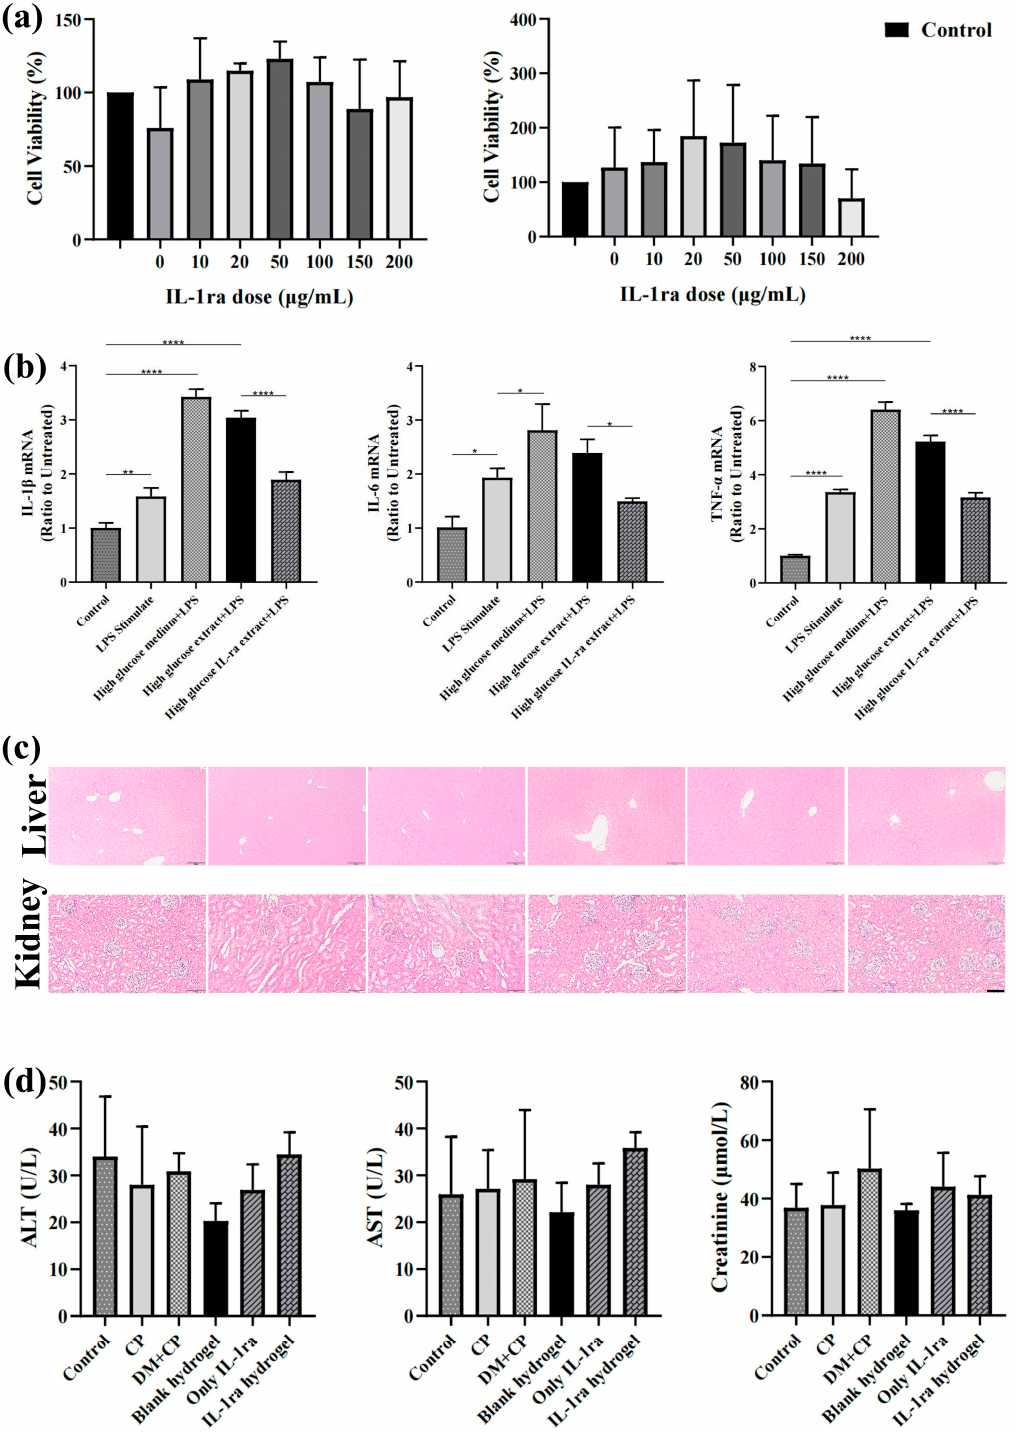
Figure 2. Biocompatibility and anti-inflammatory factor characteristics of IL-1ra-loaded CS/ β - GP/gelatin thermosensitive hydrogel. ( a ) Viability of RAW 264.7 cells cultured with IL-1ra-loaded CS/ β -GP/gelatin thermosensitive hydrogels at different concentrations (10–200 μ g/mL) at 24 h and 48 h. ( b ) Fold change of IL-1 β , IL-6, and TNF- α mRNA expression in the blank control, LPS stimu- lated, High glucose medium+ LPS stimulated, High glucose extract + LPS stimulated, High glu- cose extract + LPS + IL-1ra-loaded CS/ β -GP/gelatin thermosensitive hydrogel groups ( n = 3). ( c ) H&E staining of liver and kidney tissue in the groups I, II, III, IV, V, and VI, scale bar represents 100 μ m. ( d ) Effect of IL-1ra-loaded CS/ β -GP/gelatin thermosensitive hydrogels on serum creati- nine (Cr), aspartate transaminase (AST), and alanine transaminase (ALT) levels. *: p < 0.05, **: p < 0.01, ****: p < 0.0001. 2.3. IL-1ra CS/ β -GP/Gel Hydrogel Decreased the mRNA Expression of Inflammatory Factors Our in vitro (Figure 2b) and in vivo (Figure 3a) experiments showed similar mRNA expressions of inflammatory factors. The results of cell experiments showed that the mRNA expression of IL-1 β , IL-6, and TNF- α of RAW264.7 cells stimulated with LPS was 1.58 times, 1.91 times, and 3.35 times higher than those of untreated cells, and the ex- pression of these three cytokines increased by 2.16 times, 1.45 times, and 1.91 times, re- spectively, after high glucose culture. The expression of these inflammatory cytokines decreased significantly after treatment with IL-1ra CS/ β -GP/Gel hydrogel extract. In an- imal experiments, the mRNA expression of IL-1 β , IL-6, and TNF- α in rats with simple periodontitis was 2.63 times, 2.79 times, and 4.18 times higher than those in healthy rats, and the mRNA expression of these cytokines in rats with diabetes increased by 1.78 times, 1.58 times, and 3.04 times, respectively. The expression of inflammatory factors af- ter treatment with IL-1ra alone and blank hydrogel was not significantly different from that in the diabetic periodontitis group but was significantly decreased in the IL-1ra CS/ β -GP/Gel group ( p < 0.05).